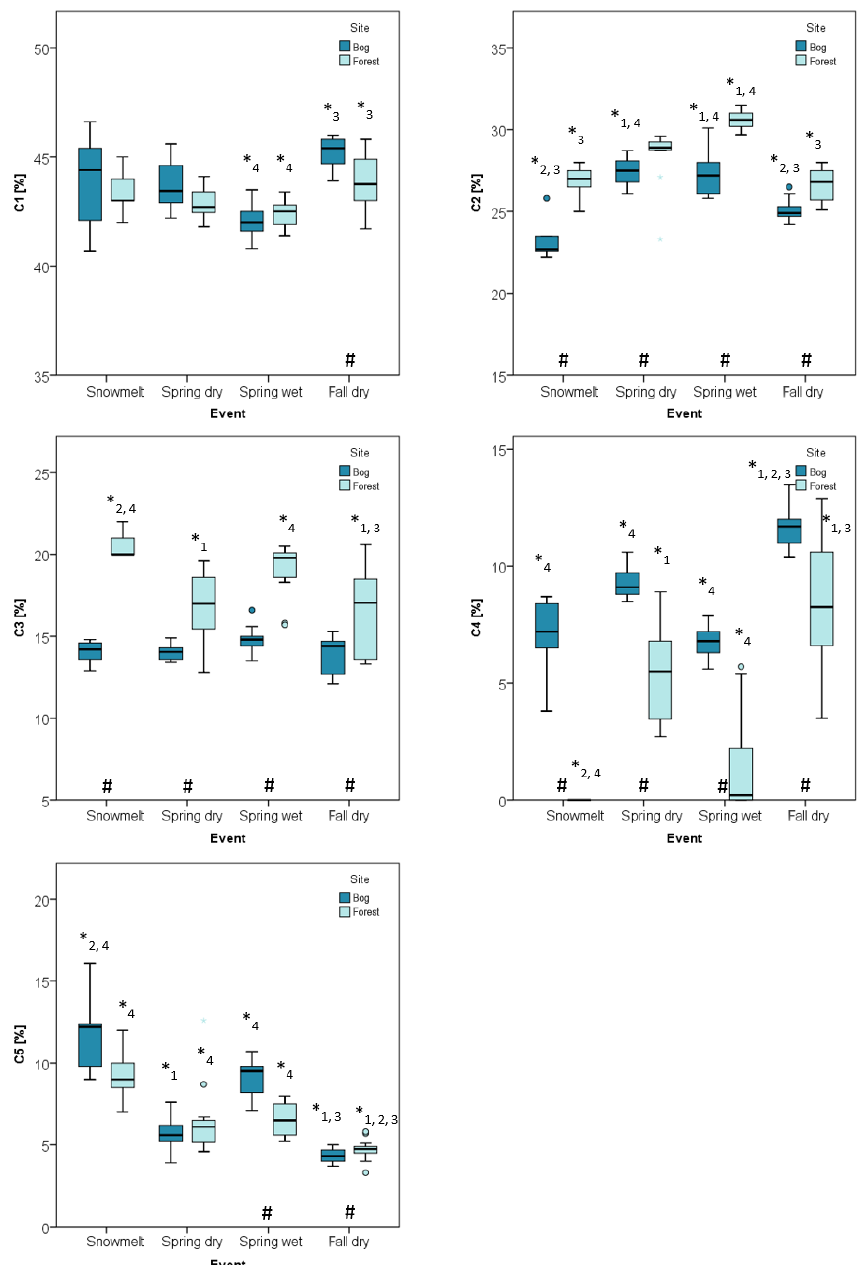
Figure 7. Box plots of PARAFAC components during events. Dark blue bars indicate the bog site, lighter blue bars the forested site. A table of descriptive statistics for each event can be found in the Supplement. Asterisks indicate a significant difference between events (Kruskall– Wallis; ρ < 0.05), which are indicated by added numbers: 1 – snowmelt, 2 – spring dry, 3 – spring wet, 4 – fall dry. Significant differences between the bog and the forested site at an event (Mann–Whitney; ρ < 0.05) are indicated by a hash. A table of descriptive statistics for each event can be found in the